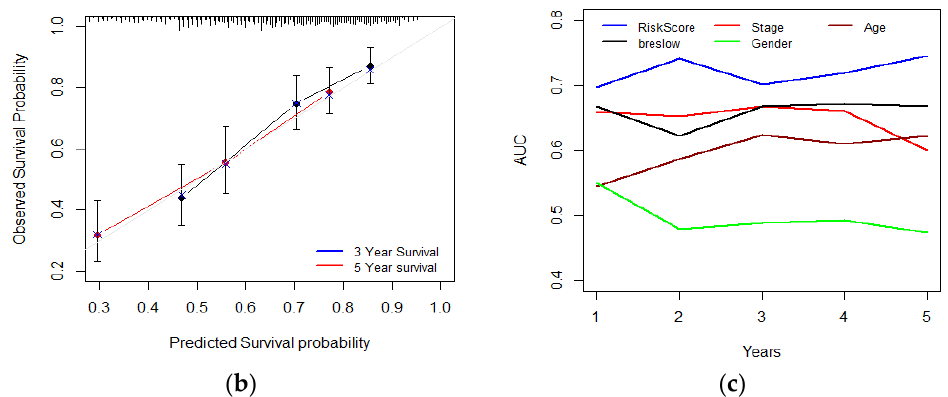
Figure 8. Developing and validating a nomogram based on the immune–related gene signature risk score model. ( a ) A prognostic nomogram created by integrating the risk score and clinical parameters; ( b ) The nomogram displays high accuracy in the calibration analysis; ( c ) AUC curves of risk score-related gene signature nomogram compared with stage, age, Breslow, and gender in the melanoma-TCGA (1 to 5 years).